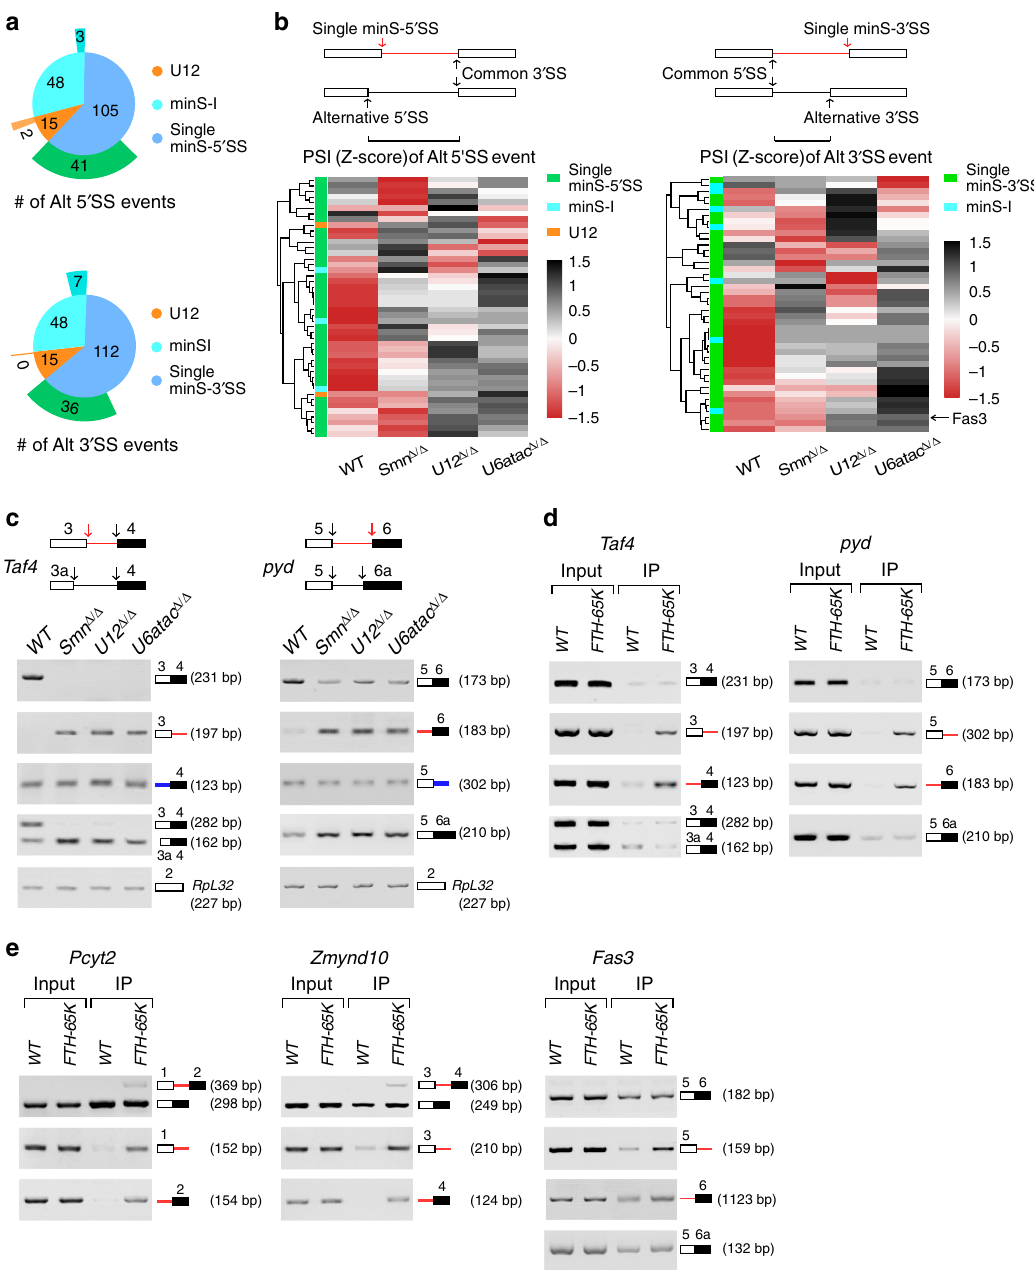
Fig. 6 Alternative selection by the major and minor spliceosomes. a Alternative splicing events that are involved with minor spliceosome sensitive SSs. Upper, alternative 5 ′ SS events identi fi ed from three categories of minS-5 ′ SSs; lower, alternative 3 ′ SS events identi fi ed from three categories of minS-3 ′ SSs. b Upper, schematics of splice sites in the minS-SS-involved AS events. Lower, splicing of introns using the alternative SSs and common SSs were increased in the minor-snRNA deletion strains. c Common SSs can be recognized by both the major and minor spliceosomes. Five sets of primers were used to amplify various pre-mRNAs and mRNAs. d Pre-mRNAs but not mRNAs of the minor spliceosome-sensitive genes are enriched by minor-speci fi c Dm65K. e Pre-mRNAs of the genetically identi fi ed three genes that rescue SMA-associated phenotypes are enriched by Dm65K. FTH-Dm65K and the WT strains were used. Red arrows and lines: minS-SSs and minS-Is; black arrows and lines: the major spliceosome recognized SSs and introns; blue lines: mixture of the minor and major spliceosomes recognized introns. Source data are provided as a Source Data fi report of P element-mediated disruptions of the U12 and U6atac genes, which caused lethality during embryonic and the third instar larval stages, respectively 7 . In the beginning of this study, we observed that two of our deletion strains were lethal at the pre- pupal stage, but showed a stable lethal phenotype at the pupation stage when the deletion strains were constructed after crossing both major and minor splicing 31,33 . The similarity of SMA- with the isogenic WT strain for 10 generations. associated phenotypes between the Smn mutants and the minor-